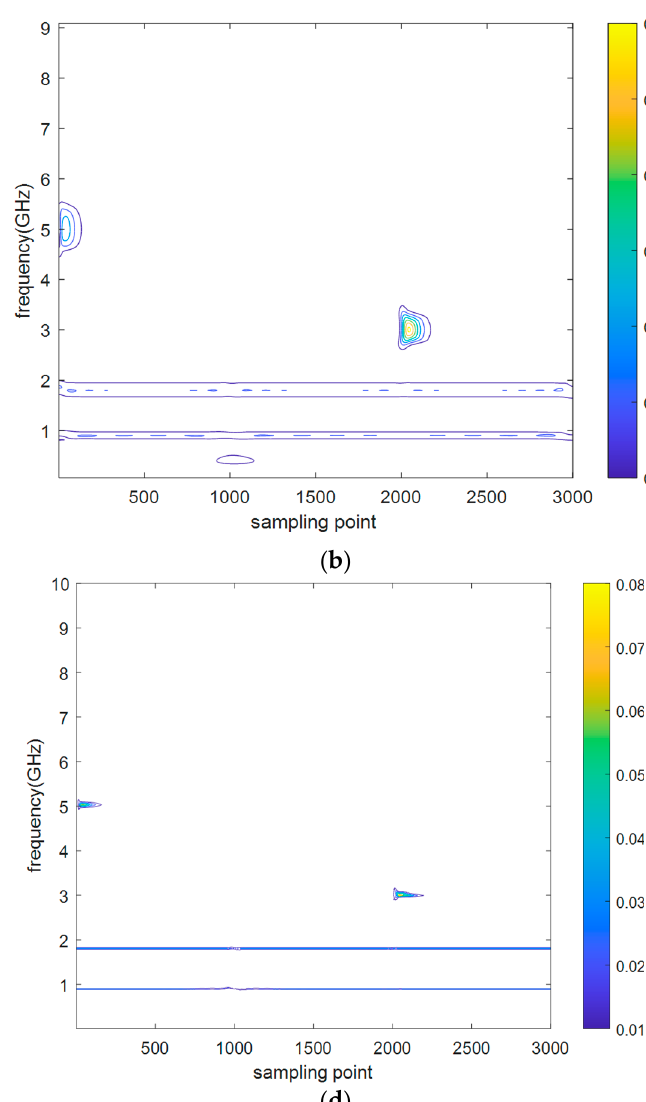
Figure 4. Noisy PD with sinusoidal noise only. ( a ) In the time domain and ( b ) in the frequency domain.